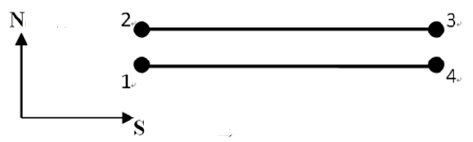
Figure 2. Goodman element schematic figure. N for normal direction. S for separate direction.